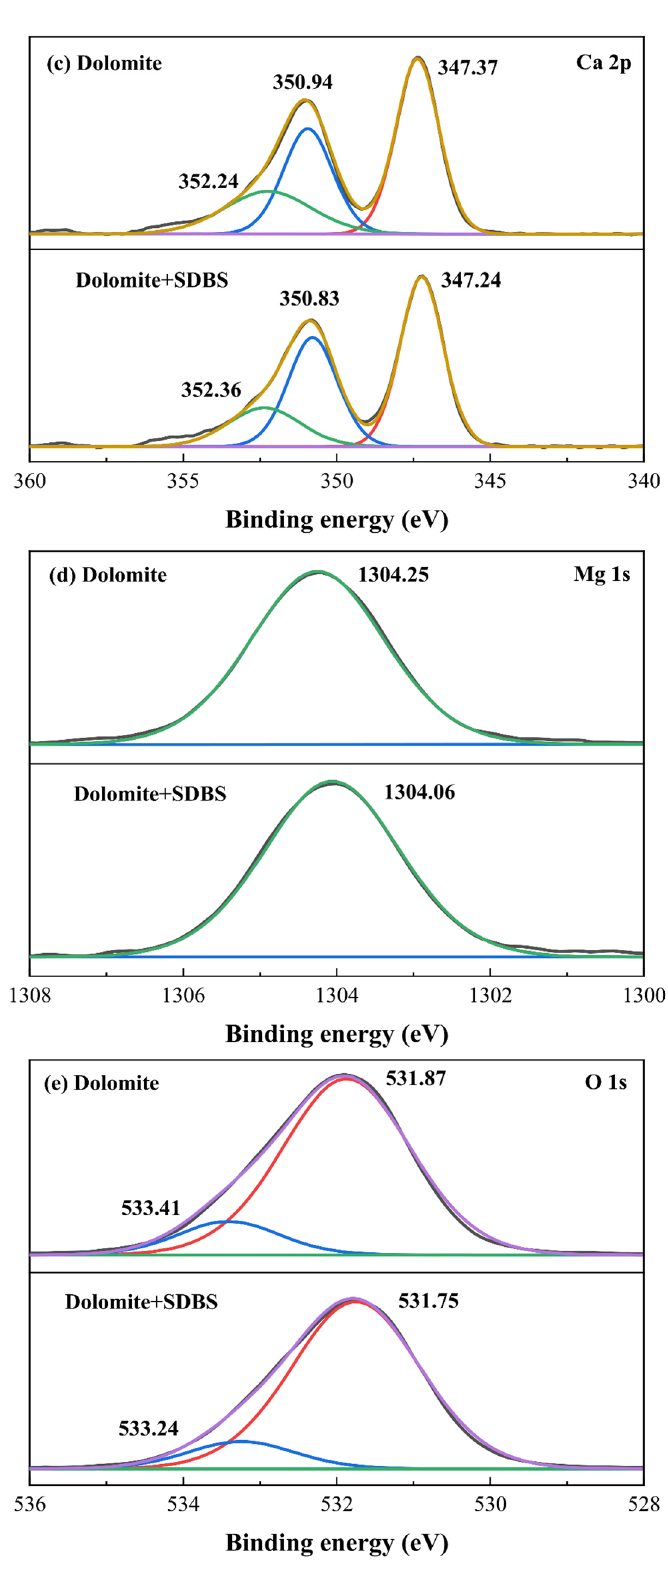
Figure 7. ( a ) S 2p, ( b ) C 1s, ( c ) Ca 2p, ( d ) Mg 1s and ( e ) O 1s of dolomite sample with and without the addition of